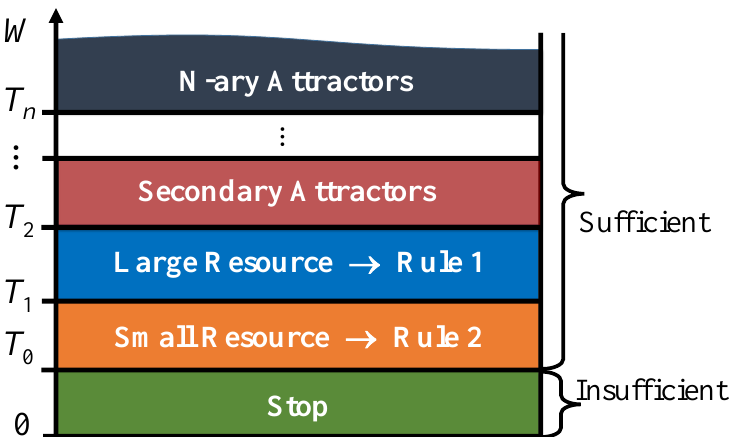
Figure 4. Threshold scheme in a resource network with greedy vertices: T 0 separates insufficient and sufficient resource values, T 1 divides the sufficient resource into small and large values, T 2 determines the interval at which the limitations on the attractors begin to apply. Attractors of the next ranks are schematically